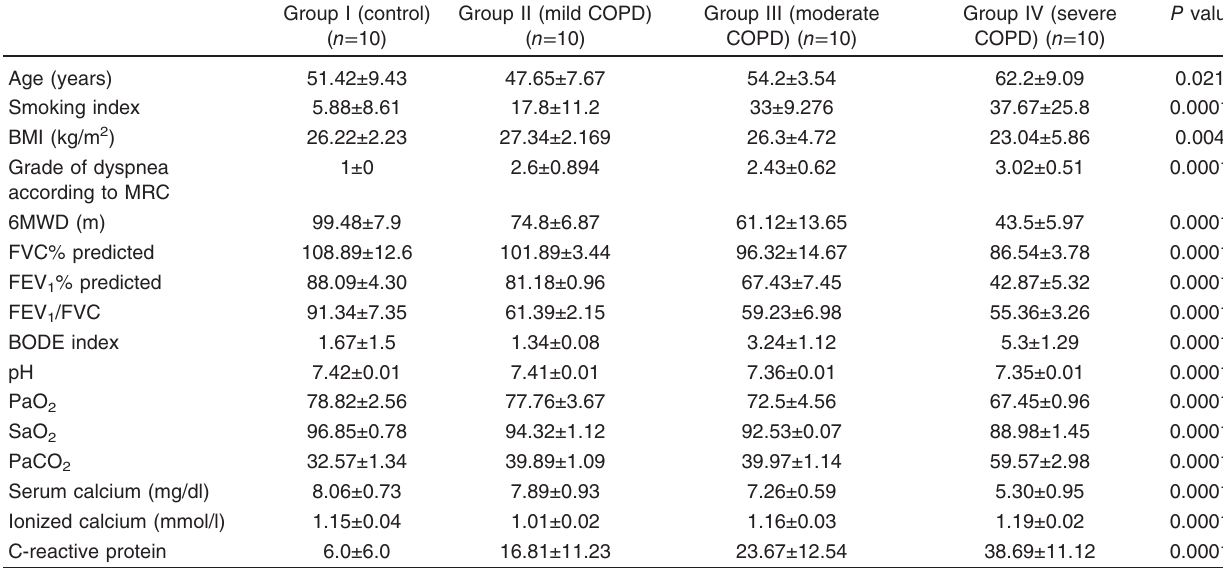
Table 1 Results of some parameters in the four studied groups